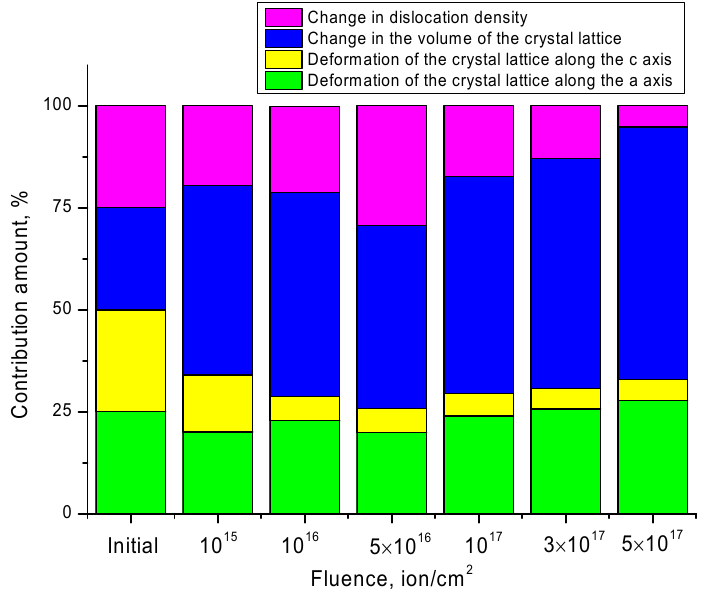
Figure 9. Diagram of the assessment of contributions to the change in radiation damage value caused by irradiation with He 2+ ions.